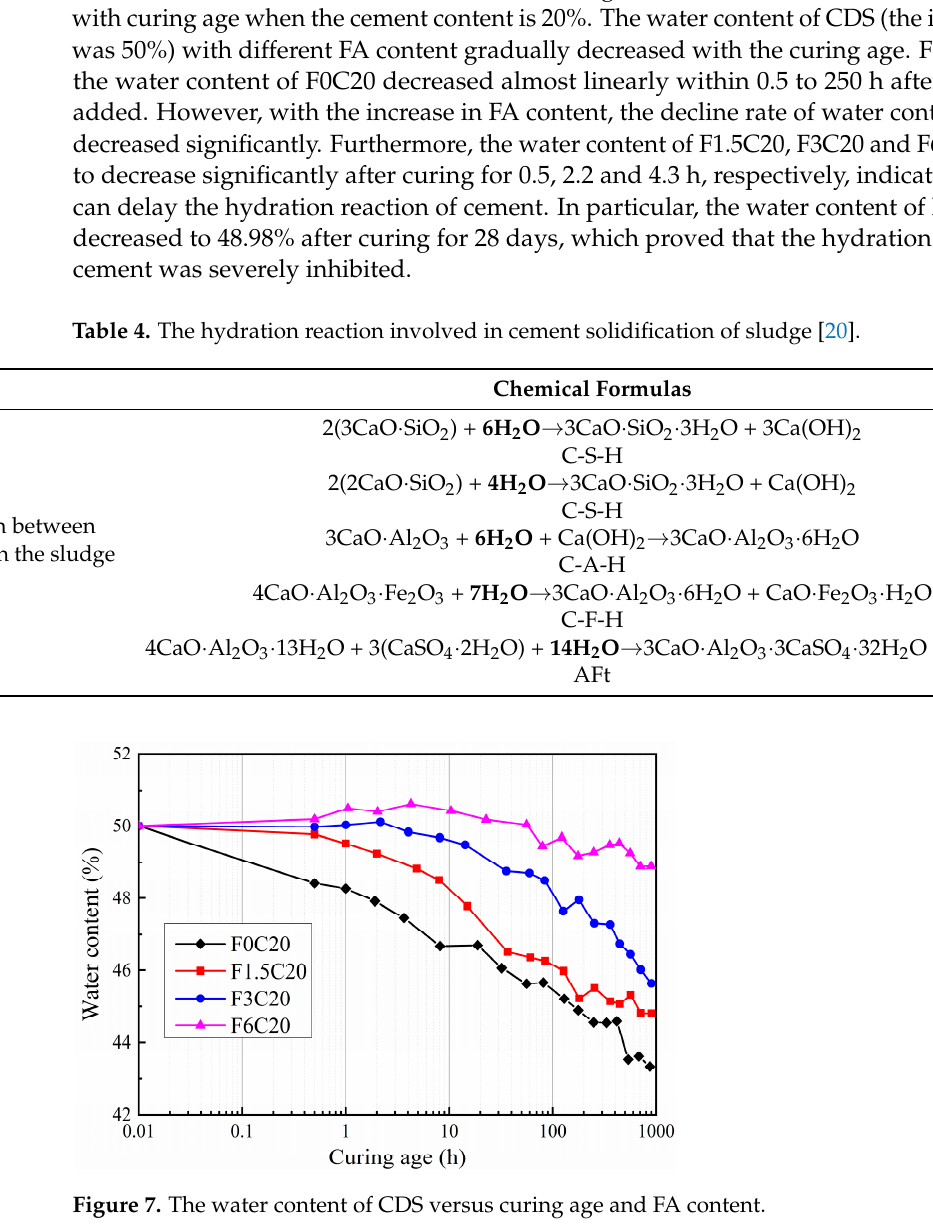
Figure 8. The hydration heat of CDS with different FA content. 3.3.2. SEM Analysis The micromorphology of CDS with different FA content cured for 28 days is shown in Figure 9a–d. Two major hydrates, acicular ettringite (AFt) and amorphous calcium sil- icate hydrate (C-S-H), were observed in all four samples. Existing studies have confirmed that the microstructure of C-S-H was controlled by curing conditions (age, temperature, etc.) or pore fluid environment, in which the irregular spherical structure is the interme- diate of transition to flake (final state) [21]. As shown in Figure 10a, a large number of acicular ettringite and spherical C-S-H were produced in F0C20. Among them, the ettring- ite with well-developed crystal structure interleaved between soil particles, forming a dense and solid structure with highest strength. It can be seen from Figure 9b that the hydrates in F6C20 were mainly small-size spherical C-S-H with poor cementation effect,